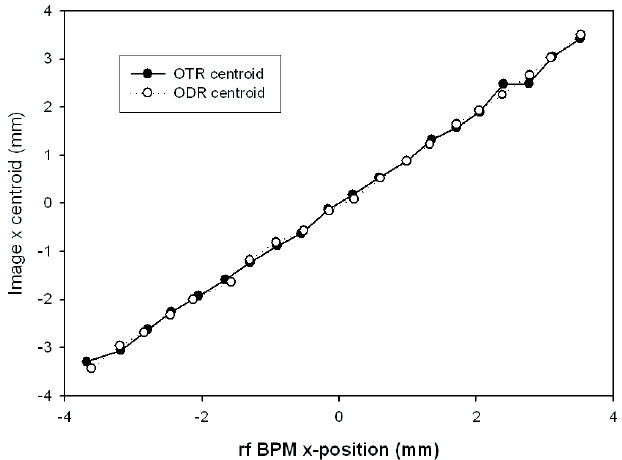
FIG. 13. A plot of the OTR and ODR centroid value changes versus the nearby rf BPM values in mm during a scan of the upstream dipole current supply (and magnet fields). Horizontal position information can be reliably obtained from the vertically polarized ODR image centroids.